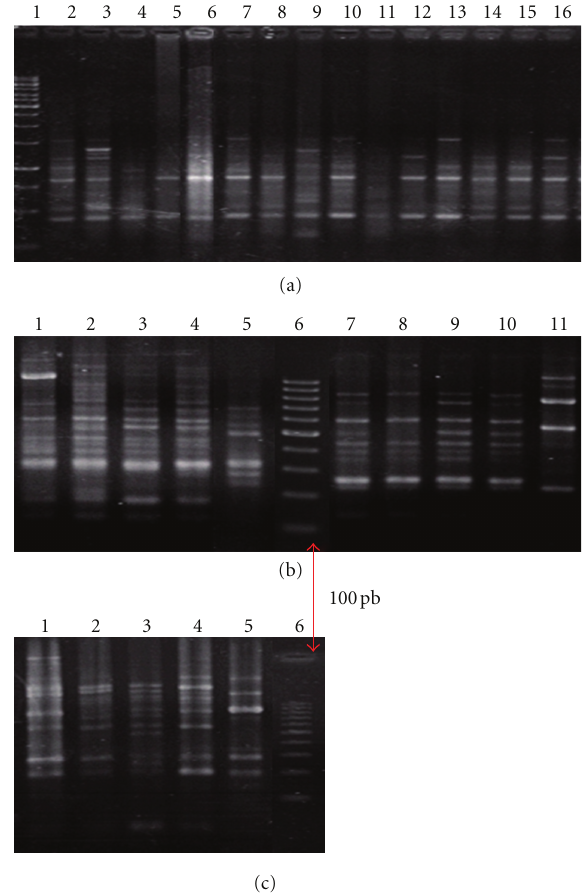
Figure 3: RAPD profiles of Serrano, Jalape˜no, and Habanero chilli peppers. (a) oligonucleotide OPE-18. 1: 1000 bp DNA ladder; 2: JT; 3: JSi; 4: JJ; 5: JP; 6: JV1; 7: JV2; 8: JTx; 9: HT; 10: ST; 11: